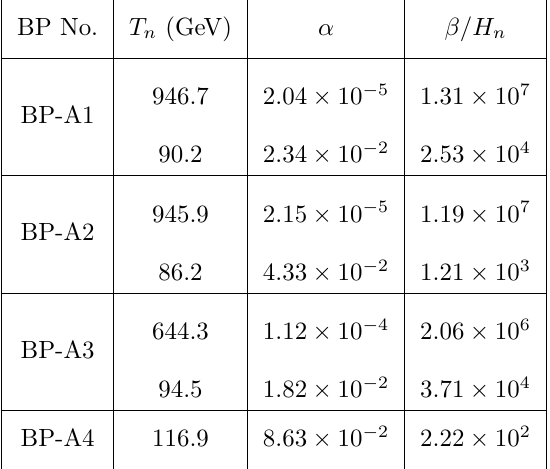
Table 6. Values of the parameters T n , α and β/H n (that control the GW intensity) for the benchmark points presented in table